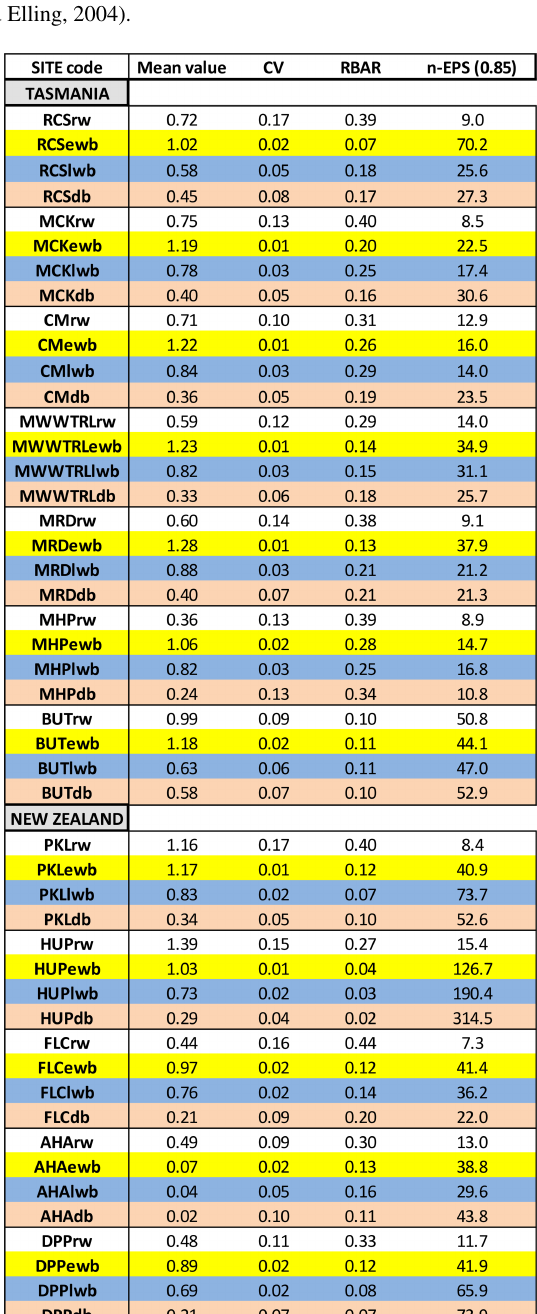
Table A1. Mean RW, EWB, LWB, and DB values for the raw chronologies. Coefficient of variation (CV) and mean inter-series correlation (RBAR) are calculated from the 20-year spline de- trended chronologies. n -EPS reflects the number of series needed to attain an EPS value of 0.85 related to the RBAR value (Wilson and Elling,